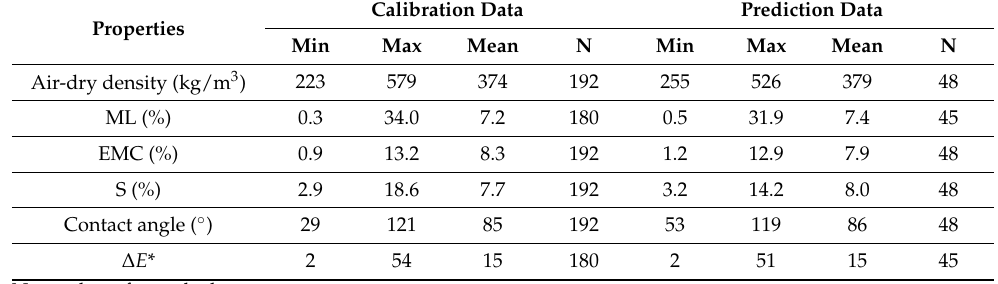
optimal LVs of air-dry density, ML, EMC, S, contact angle, and Δ E * were 4, 5, 5, 5, 4, and 4, respectively (Table 4). N: number of sample data.